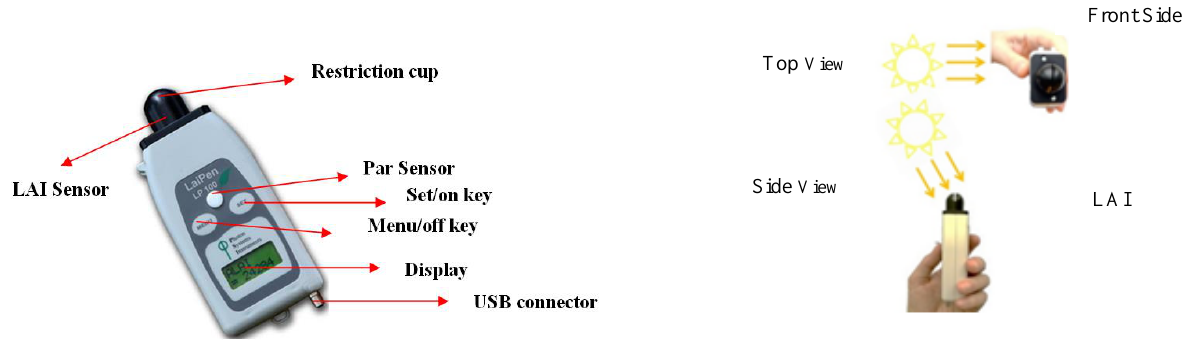
Figure 2. Elements of LP 100 device ( left ) and its correct position for calculating ALAI ( right ) (Laipen LP 100 Manual, 2015).